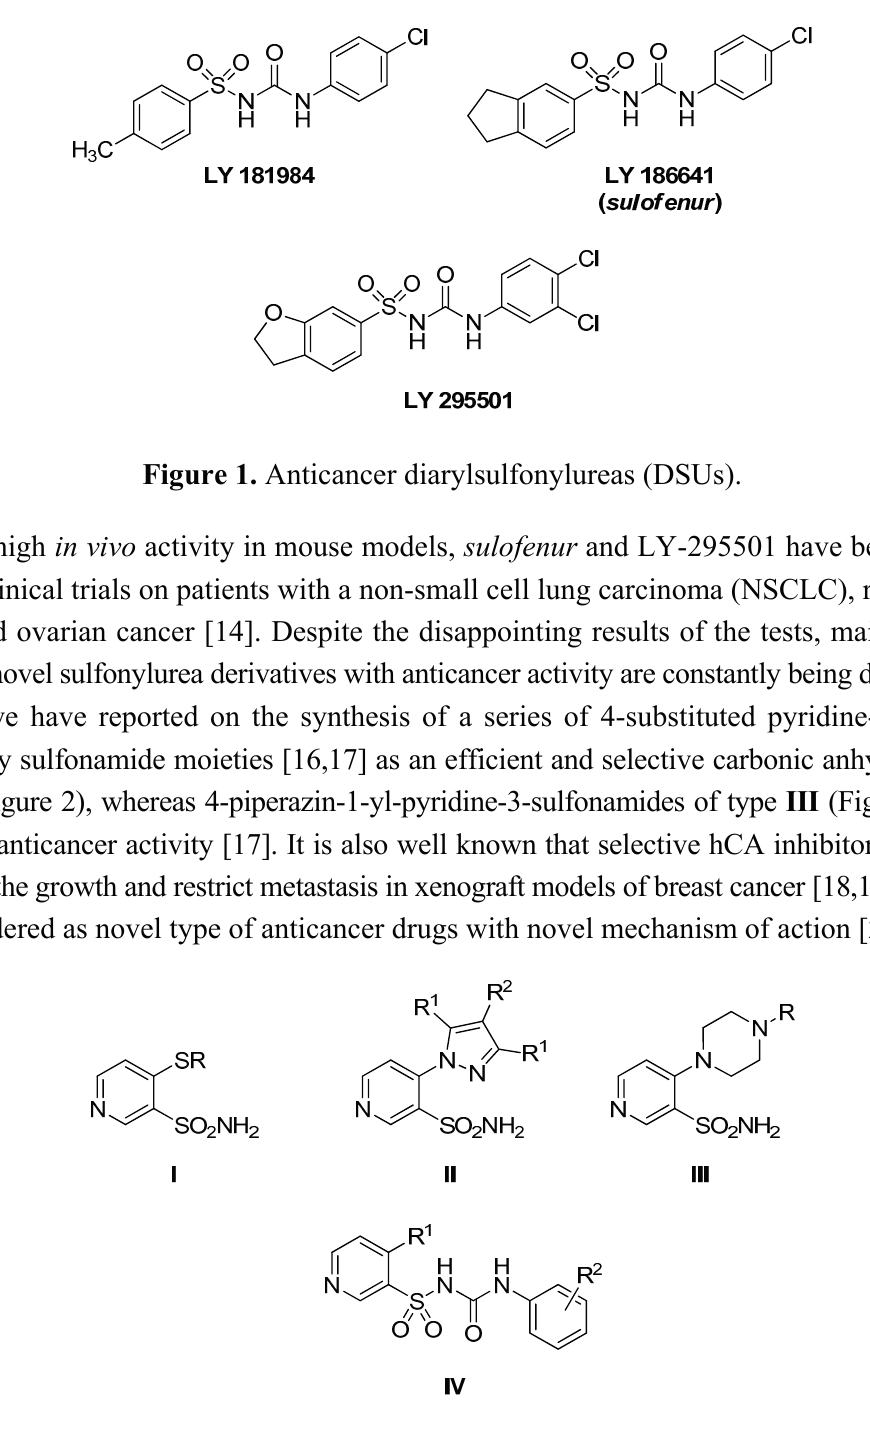
Figure 2. General structure of 4-substituted pyridine-3-sulfonamide